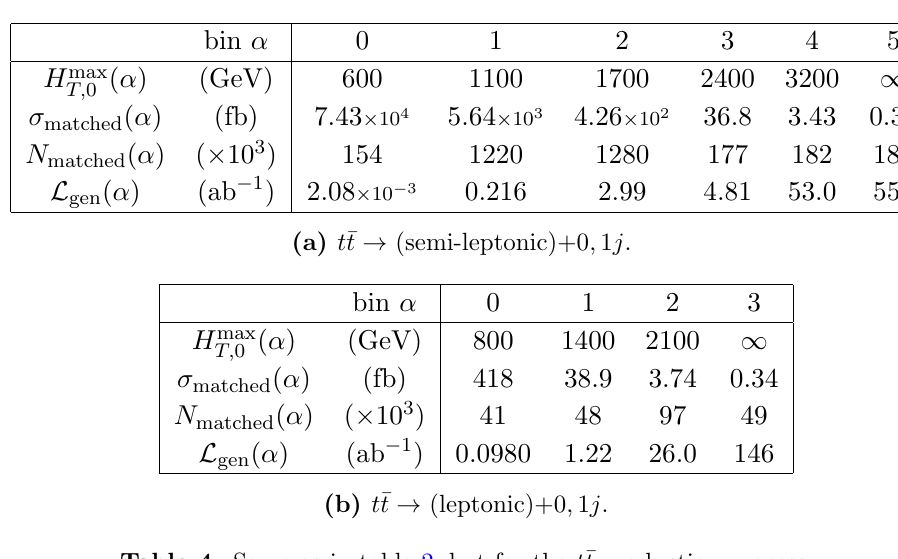
Table 3. Same as in table 2, but for the W production process.